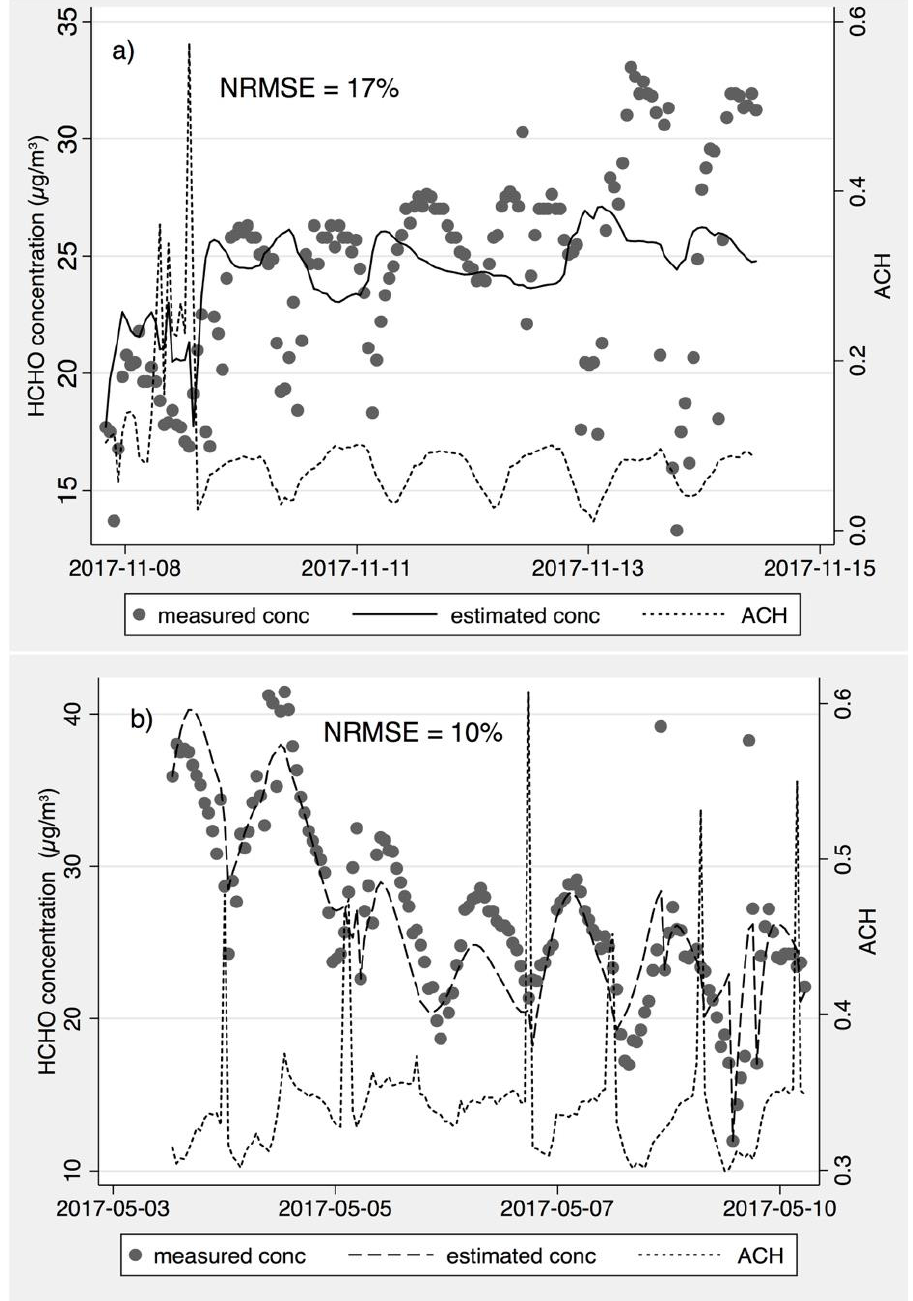
Figure 5. Examples of ( a ) a poor predictor and ( b ) a good predictor, by plotting time-resolved measured and estimated formaldehyde concentrations along with the air exchange rate per hour.